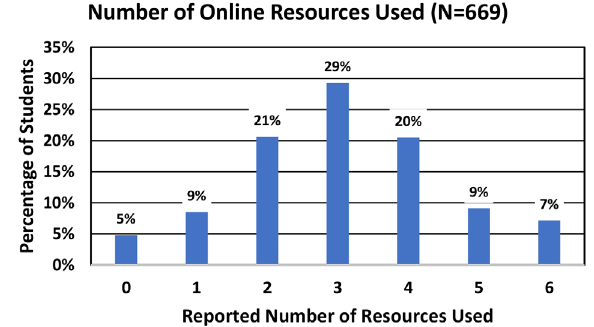
each student. Results were combined across all three courses.